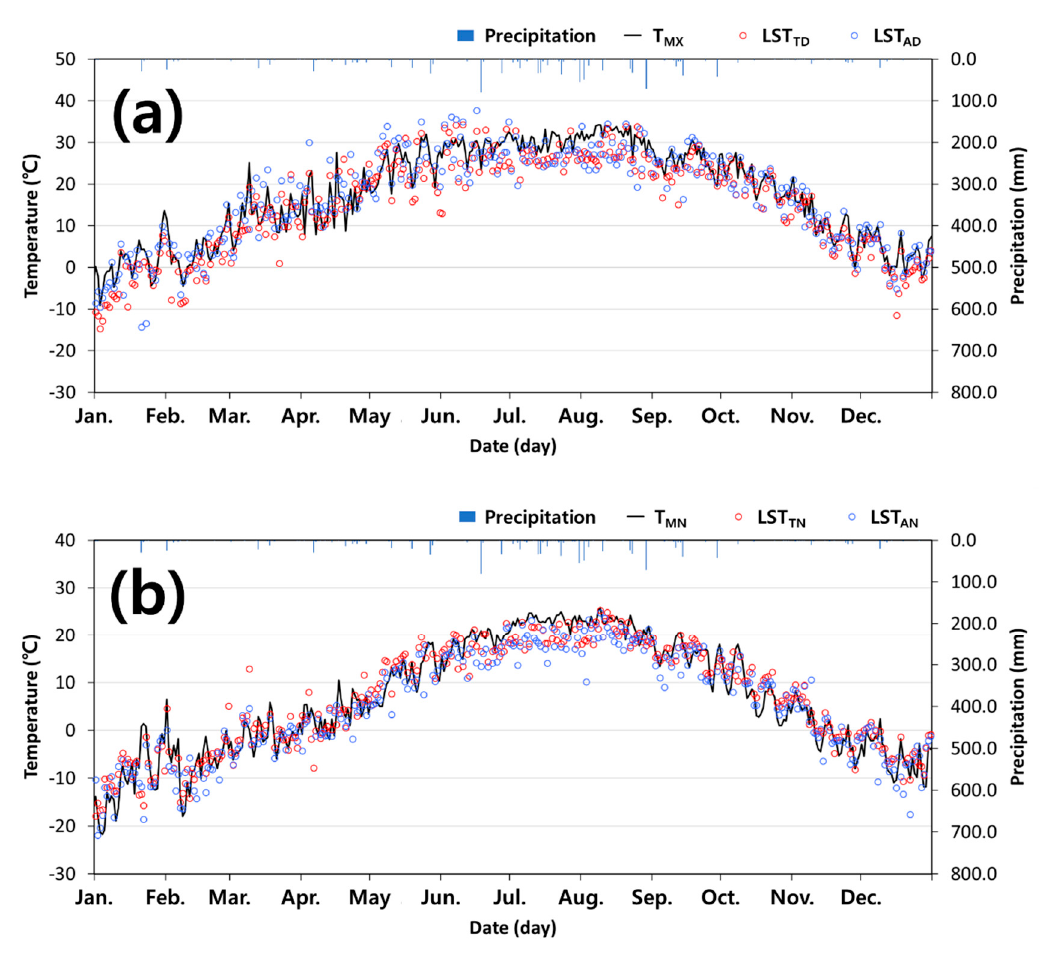
Figure 5. Comparison between ( a ) daytime MODIS LSTs (LST TD and LST AD ) and T MX , ( b ) nighttime MODIS LSTs (LST TN and LST AN ) and T MN for the Chungju weather station of the average year. Table 2. Comparison of SATs (T MX , T MM , and T MN ) and LSTs (LST TD , LST TN , LST AD , and LST AN ) for the whole period, cold wave period, and heat wave period.